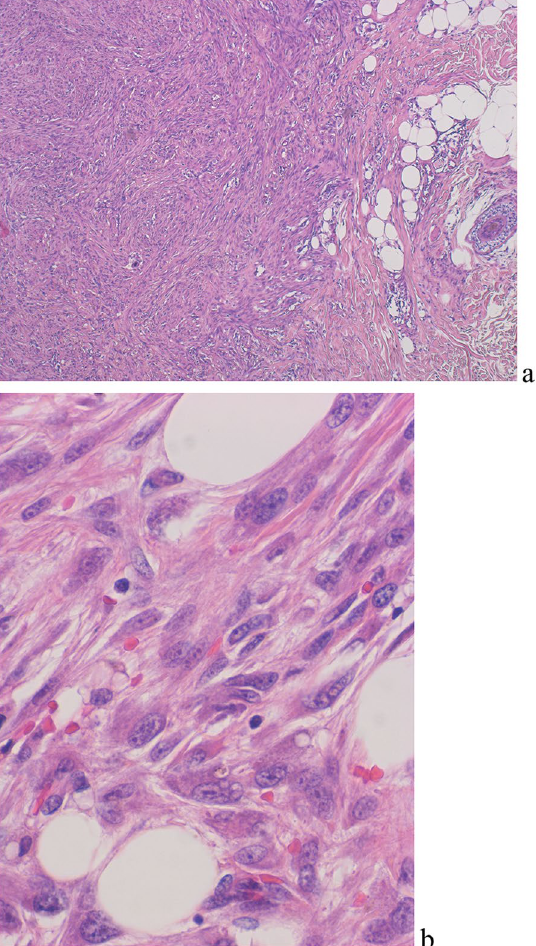
Fig. 3 Pathology of surgical specimen revealed